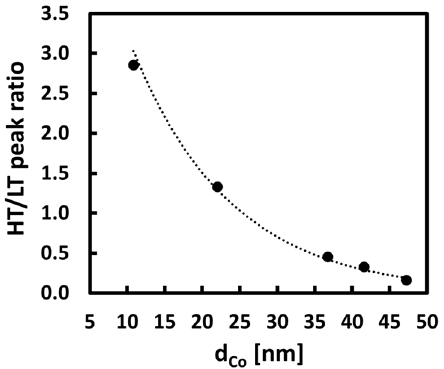
Figure 9. Correlation between the high- and low-temperature H 2 desorption peak ratio and Co particle average size of the Co/Nd 2 O 3 catalysts. Large dots represent particle sizes calculated on the basis of H 2 -TPD results (d H2-TPD, vide Table 3).